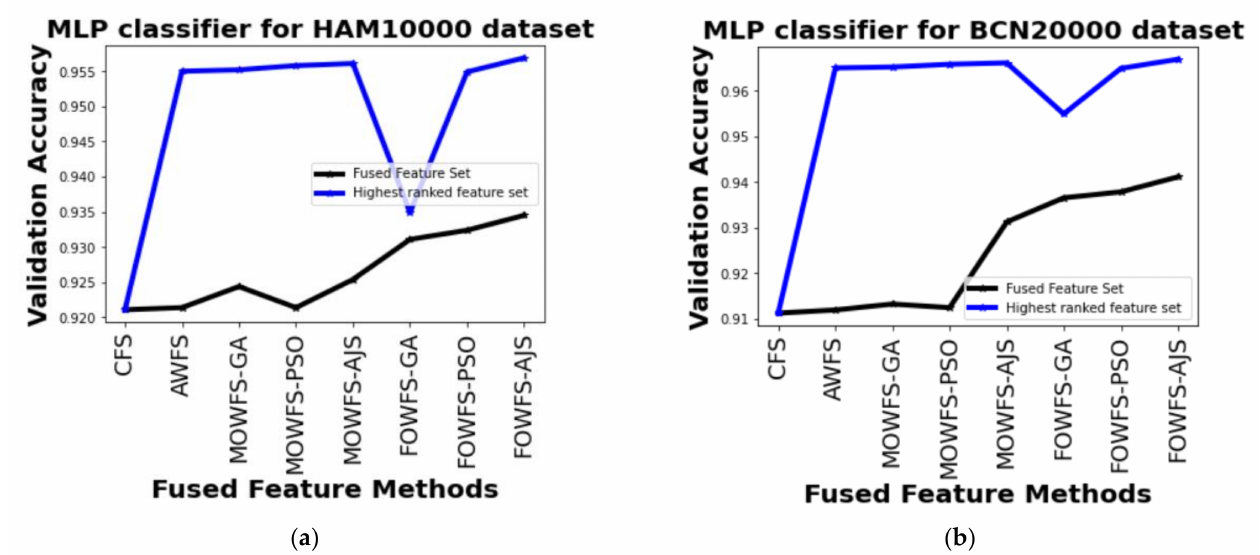
Figure 8. Comparison of validation accuracy for fused feature set and highest ranked feature set